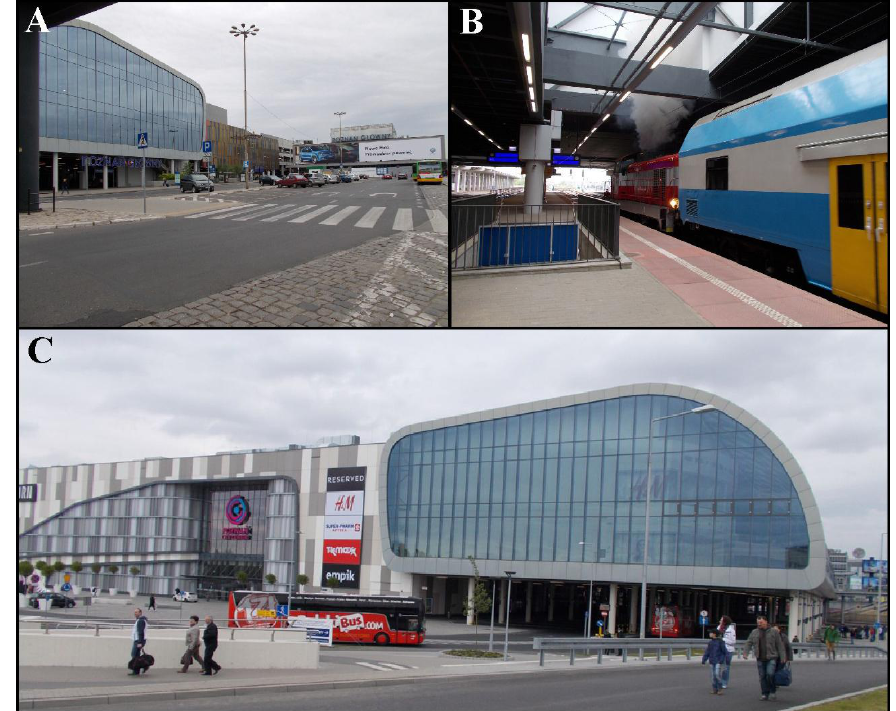
Fig. 7. The old and new railway station buildings in Poznań (A), one of the platforms under the new station building (B), and long-distance bus station, as well as a shopping centre with services (C)